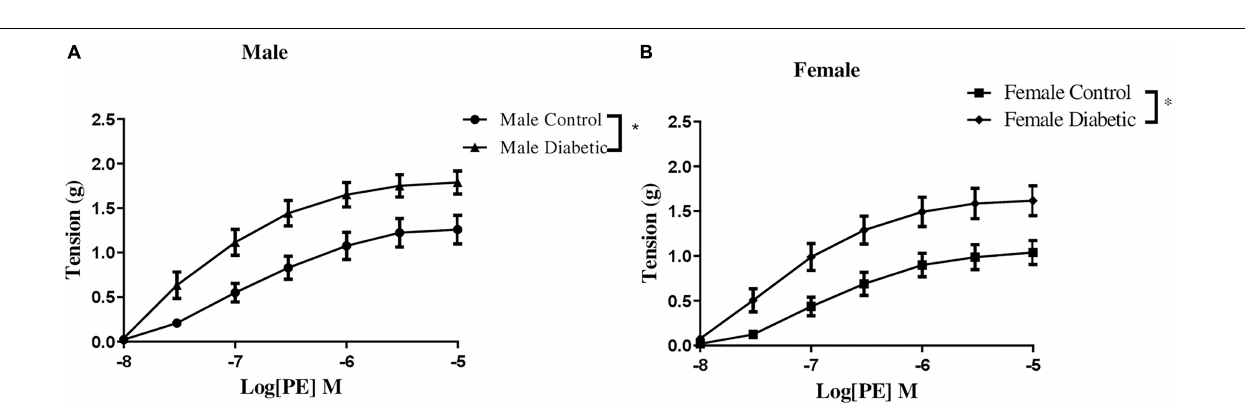
FIGURE 4 | Western blot analysis IK Ca and SK Ca expression in control and UCD-T2DM rat aorta. Protein levels of (A) aortic intermediate conductance calcium activated potassium channel (IK Ca ) and (B) small conductance calcium activated potassium channels (SK Ca ) were measured from the samples of male control and diabetic rats. IK Ca (A) and SK Ca (B) were quantified by densitometry and normalized to corresponding GAPDH. Values are represented as mean ± SEM. Each bar represents the values obtained from n = 4–5 per group. To show representative bands, images from different parts of the same gel have been juxtaposed, indicated by white dividing lines. Capped lines indicate significant differences between two groups ( p < 0.05), as analyzed by unpaired Student’s t -test. MC, male control; MD, male diabetic.